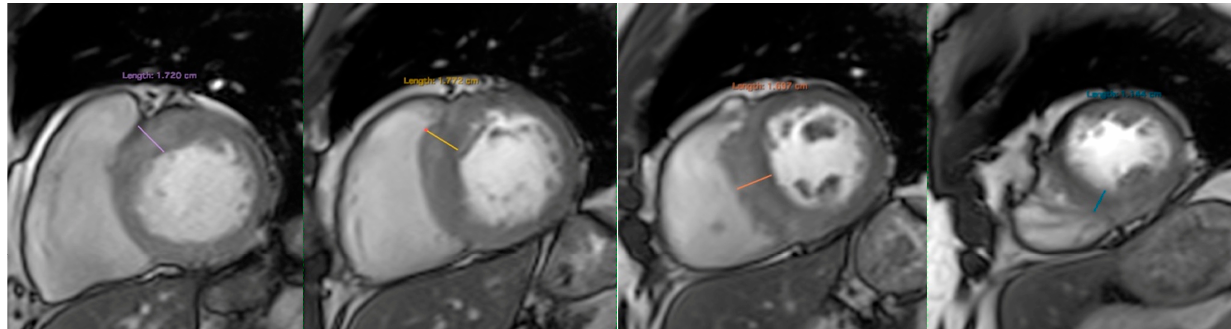
Figure 1. LV mass measurement on short-axis using CMR .